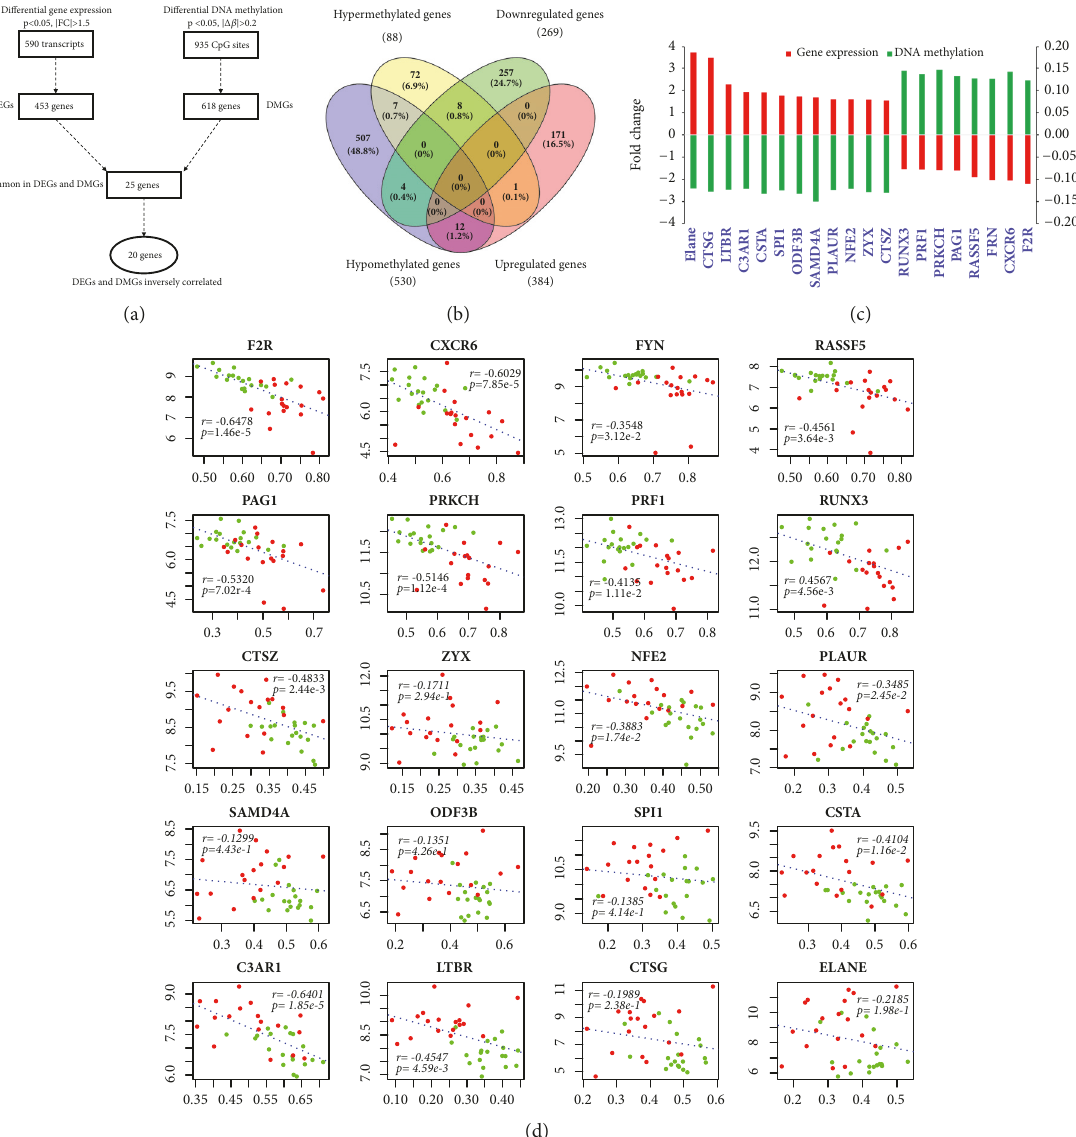
Figure 3: The genes that shows the most significant changes in D NA methylation and gene expression. (a) Flowchart of identification of genes showing coordinately changed DNA methylation and gene expression. (b) Venn diagram of differential DNA methylation and differential gene expression analysis. (c) The top-rank relevant differentially methylated sites with different gene expression in SSc compared with controls. The 1 st y-axis represents fold change of gene expression between SSc and normal control. The 2 nd y-axis represents Δ𝛽 of DNA methylation between SSc and normal control. (d) Correlation plots of DNA methylation versus gene expression in SScs and normal for the most significant changes in DNA methylation and gene